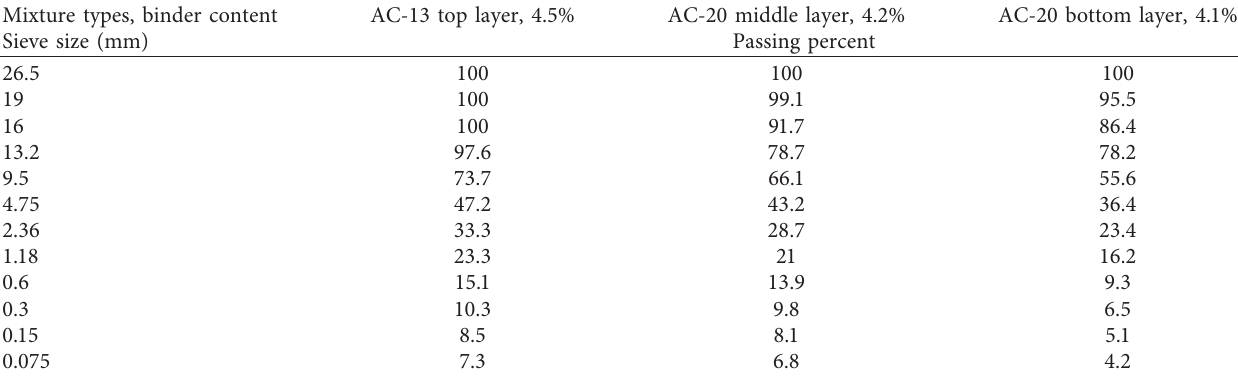
Table 1: Aggregate gradations and binder content of each layer.